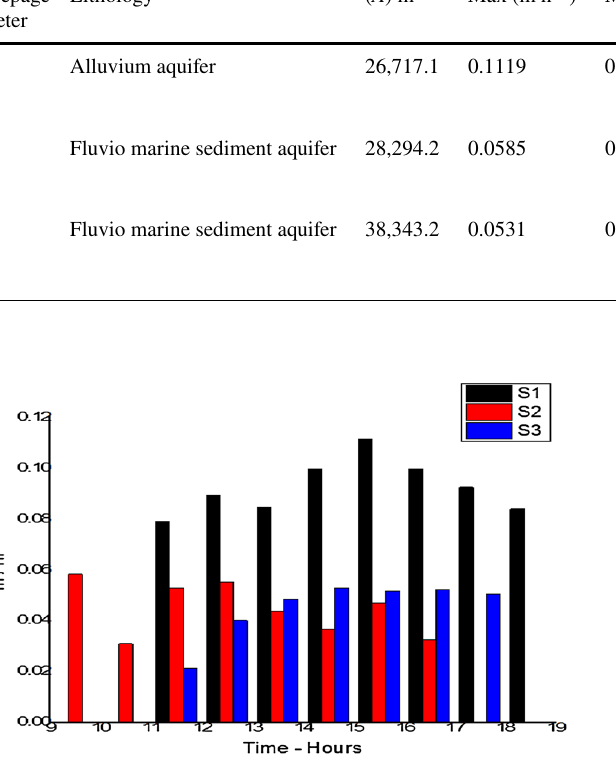
Fig. 4 SGD from the seepage meters Table 4 Physiochemical parameters of the seepage